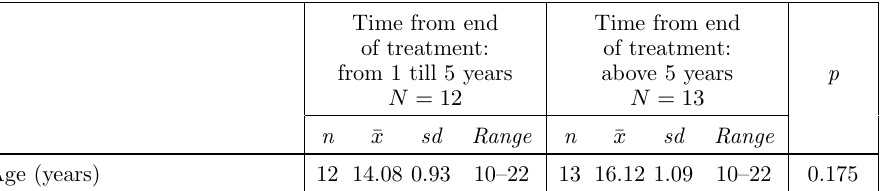
Table 2. Comparison of the mean age in groups related with time from treatment